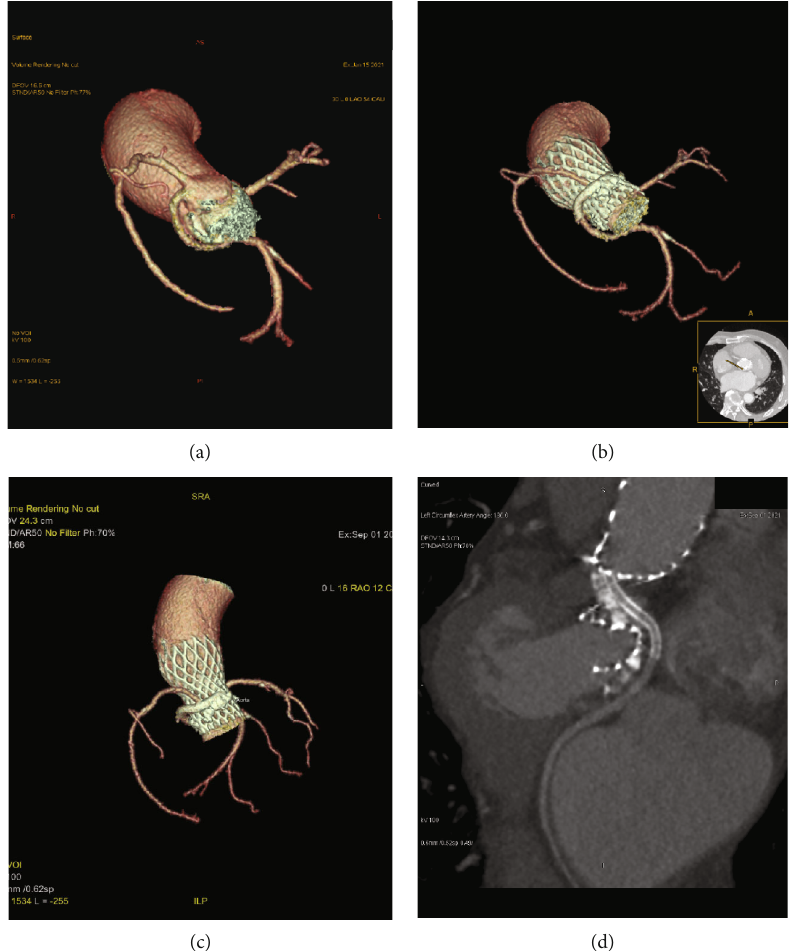
Figure 3: Six-month follow-up results after TAVR. (a) Cardiac computed tomography angiography showed a circum fl ex branch originating from right coronary sinus before TAVR. (b – d) Six-month follow-up after TAVR. CTA of the aortic and coronary regions suggested unobstructed coronary fl ow of the